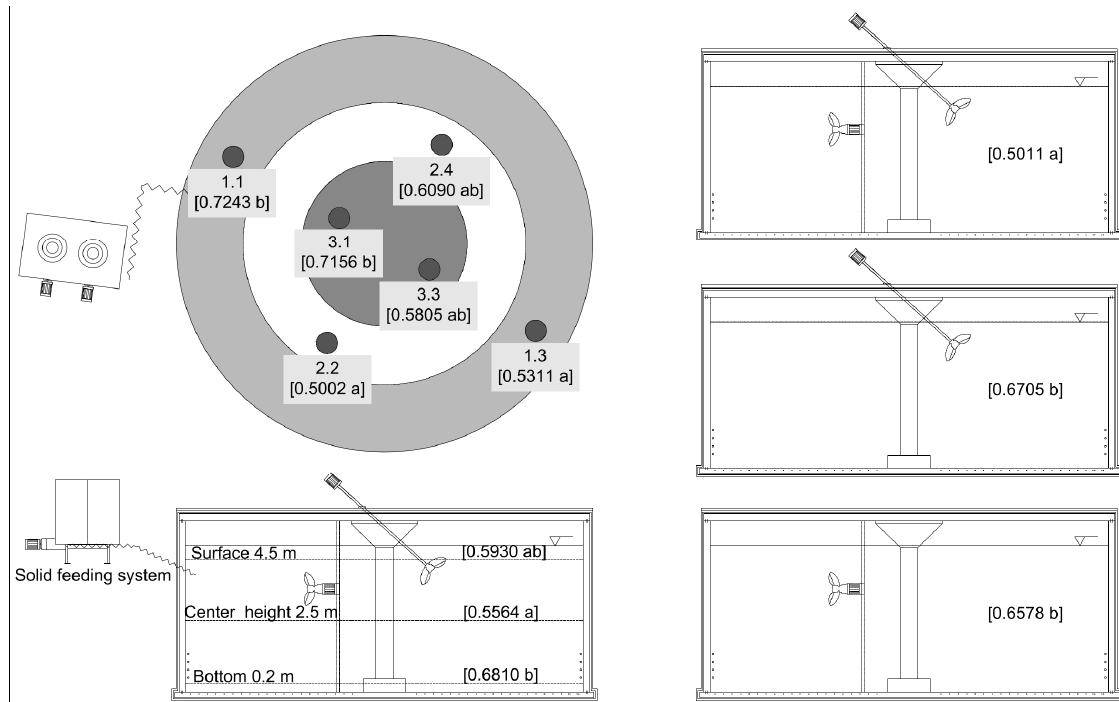
Figure 5. Schematic drawing of the results of comparison of the significance test of acetic acid (values in